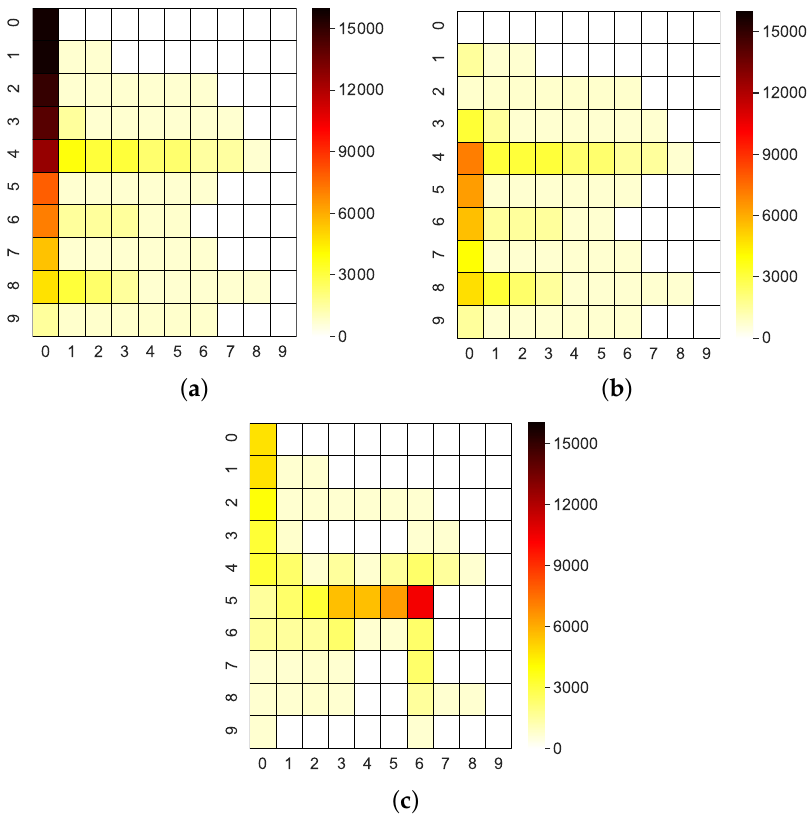
Figure 5. Traffic heatmaps. ( a ) C1 (RPL in non-storing mode); ( b ) D1 (RPL in storing mode); ( c ) D2 (proxy selection